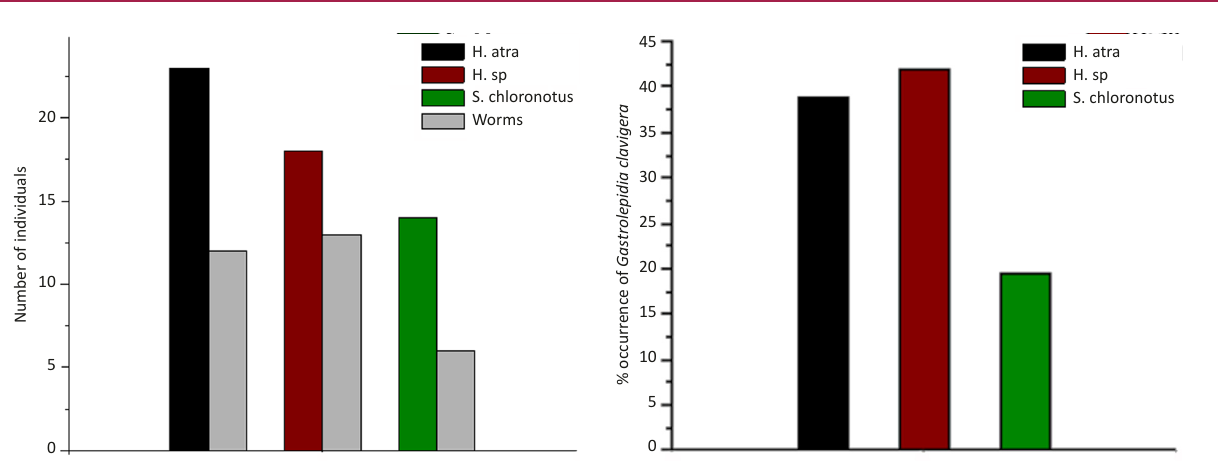
Figure 3. Percentage (%) occurrence of G. clavigera associated with three species of